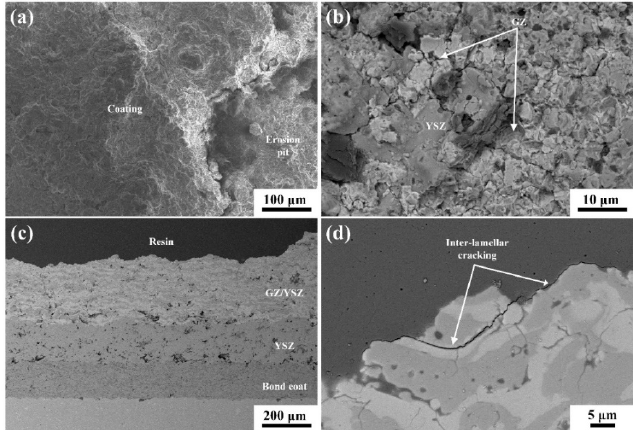
Figure 11. SEM micrographs of GZ/YSZ TBC after the erosion test: ( a ) low magnification top view, ( b ) high magnification top view, ( c ) low magnification cross section view, and ( d ) high magnification cross-section view.